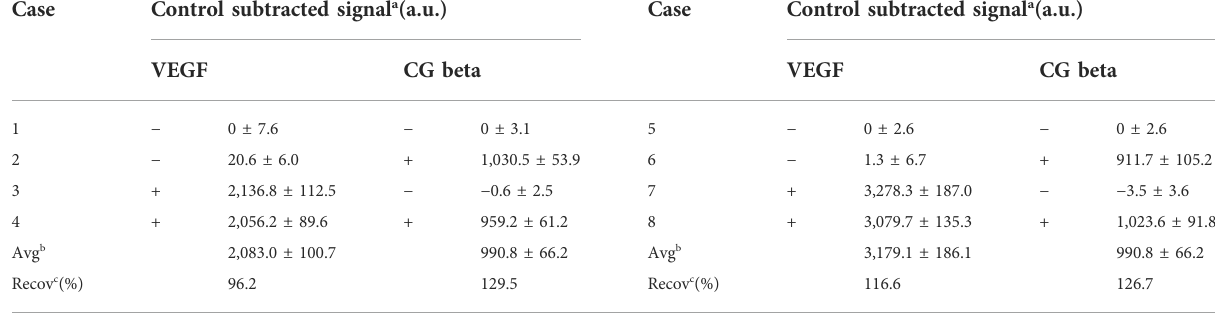
TABLE 2 Multiplex detection results for VEGF and CG beta, and their recovery rates. Case Control subtracted signal a (a.u.) Case Control subtracted signal a (a.u.) VEGF CG beta VEGF CG